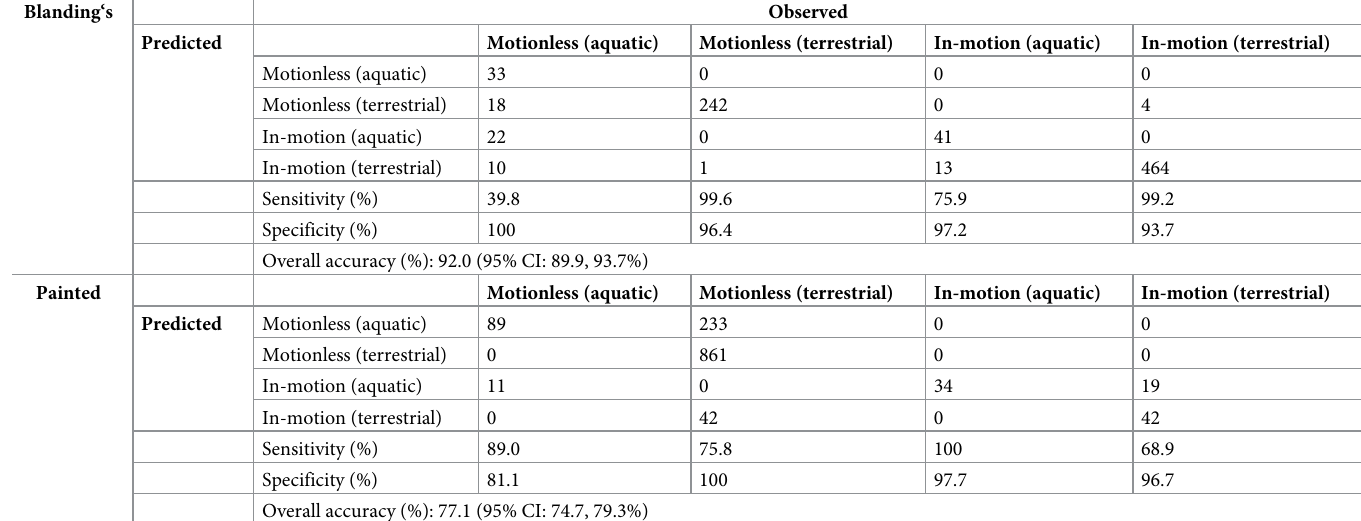
Table 2. Overall classification performance for the testing data used to classify Blanding’s turtle and Painted turtle activity based on accelerometry and water sensor data, sampled at 1 Hz. Blanding‘s